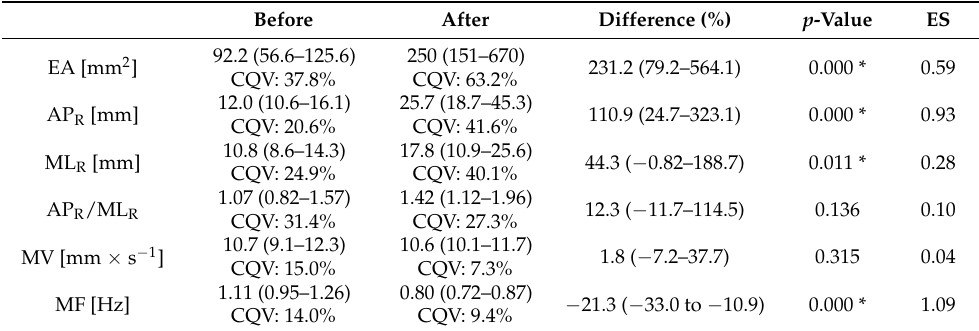
Table 3. Postural control indices before and after the effort (eyes open).